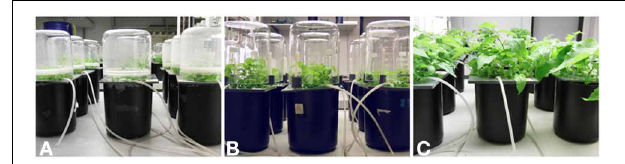
FIGURE 3 | Hardening of Populus × canescens plantlets in a hydroponic system. The plants are shown after 1 week (A) , 2 weeks (B) , and 3 weeks (C) in hydroculture.